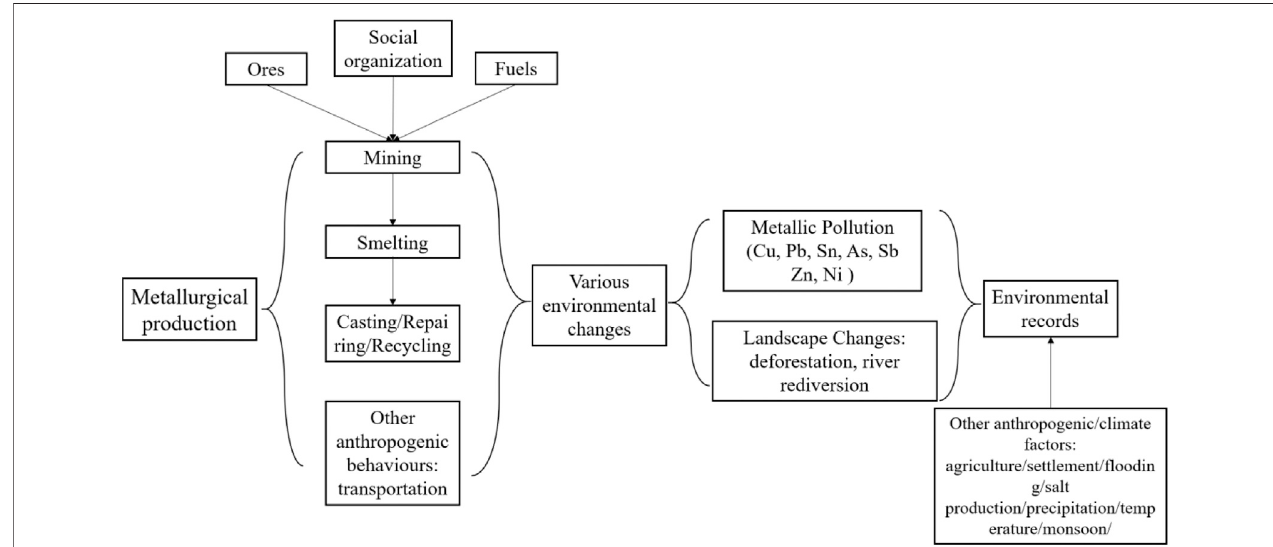
FIGURE 1 | Potential environmental changes caused by metallurgical